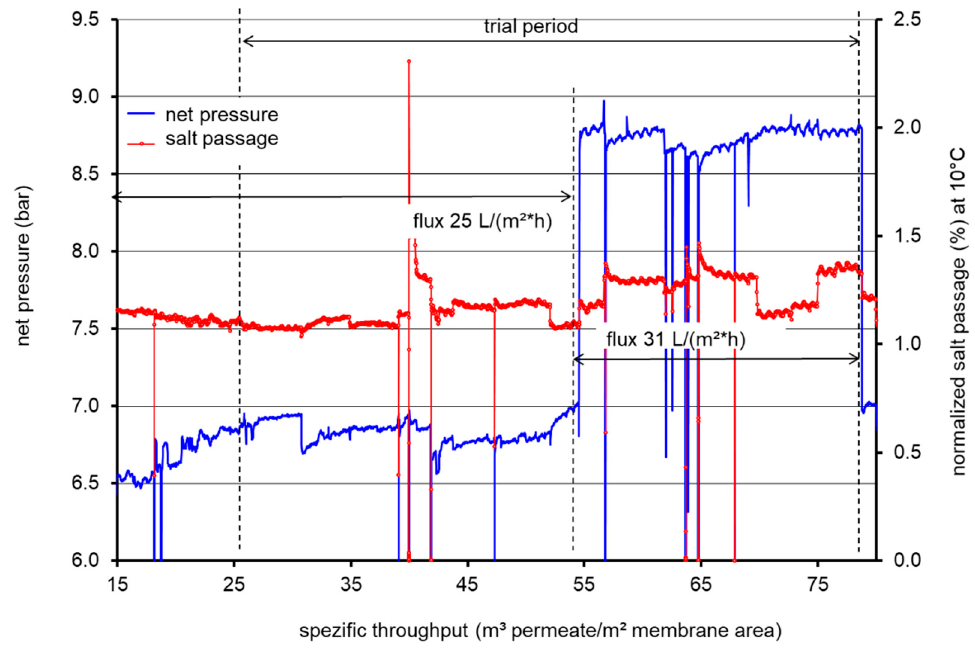
Figure 3. Net pressure and normalized salt passage for LPRO operation during the piloting period of 5 months; zero pressure indicates system shut- downs.